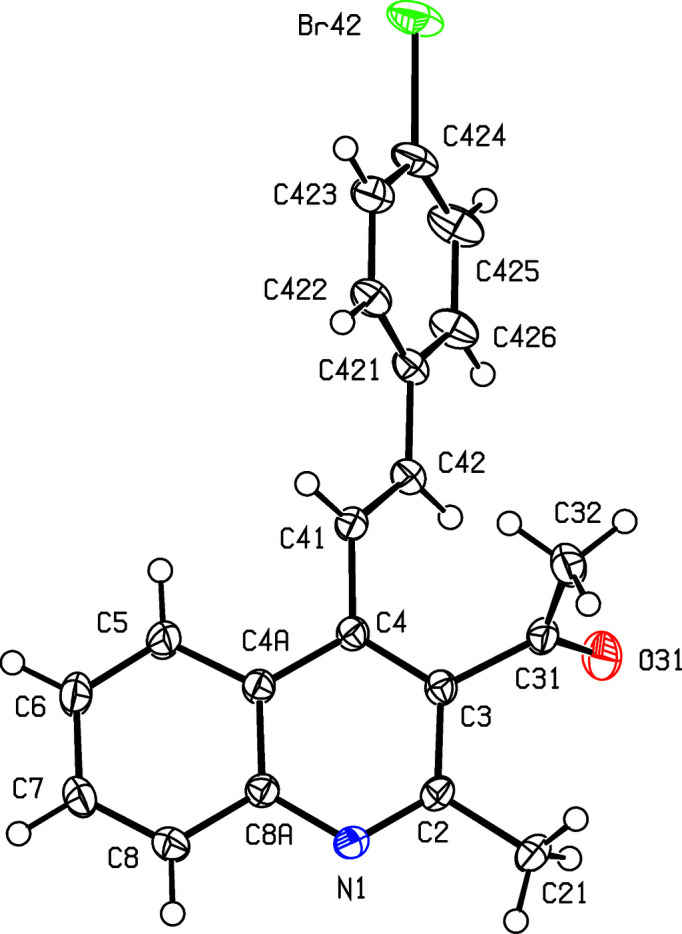
The mol­ecular structure of com­pound (II), showing the atom-labelling scheme. Displacement ellipsoids are drawn at the 50% probability level.